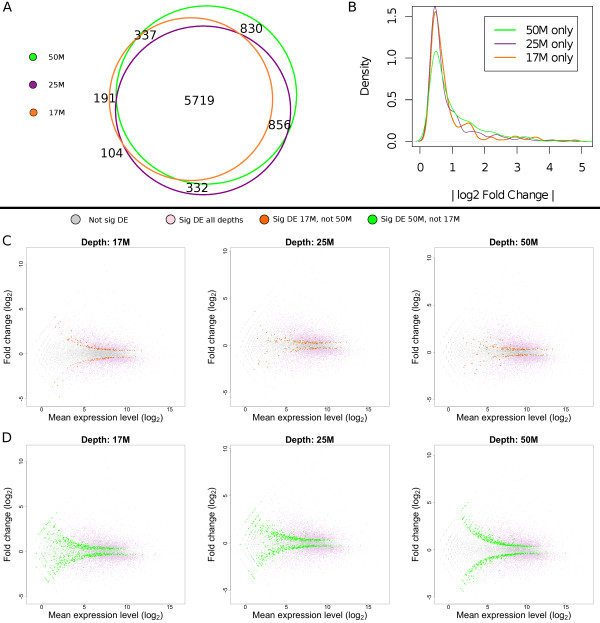
Sequencing depth and the detection of differentially expressed genes. A) Venn diagram showing the overlap between the total numbers of DE genes found at the different sequencing depths. B) Distributions of absolute log2 fold changes for the DE genes found at each sequencing depth. C) The 194 genes deemed as DE exclusively at 17 M read depth (but not at higher read depth), plotted as log2 read count vs. log2 fold change at three distinct read depths (orange points), along with not significantly DE genes (grey points) and genes significantly DE at all read depths (pink points). As read depth increases, the estimated fold changes for genes with low mean read count decreases, suggesting that the estimation of DE at lower sequencing depths suffers from sampling errors for genes with low read count. D) More plots of log2 read count vs. log2 fold change for all genes at all three respective sequencing depths. Genes detected as DE exclusively at a 50 M read depth (896 genes in total) are shown as green points.